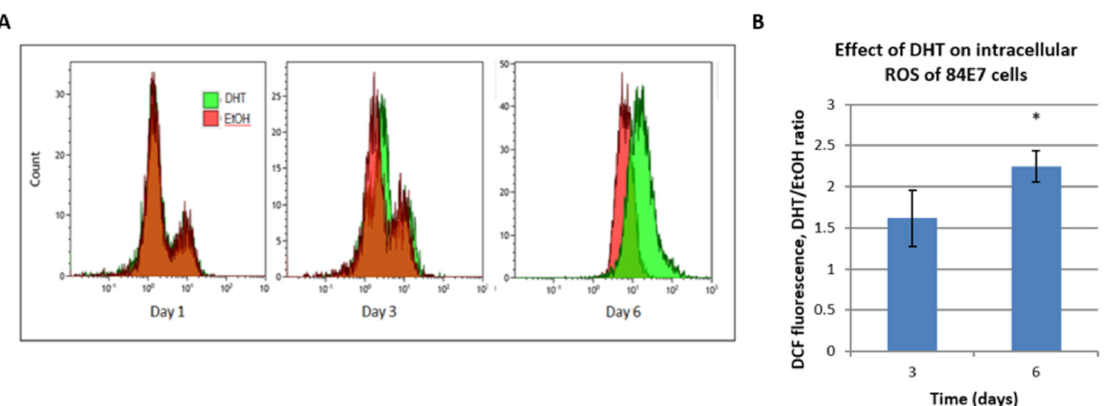
Figure 9. Effect of continuous AR activation on the induction of reactive oxygen species (ROS) in 84E7 cells: ( A ) Flow cytometry demonstrated that AR activation progressively increased ROS content in 84E7 cells, as measured using H2DCF-DA dye. Note the Y -axis scale difference. ( B ) Quantification of the flow cytometry data revealed a significant > 2-fold increase in intracellular ROS levels in DHT-treated 84E7 cells over control on day 6 (* p -value <